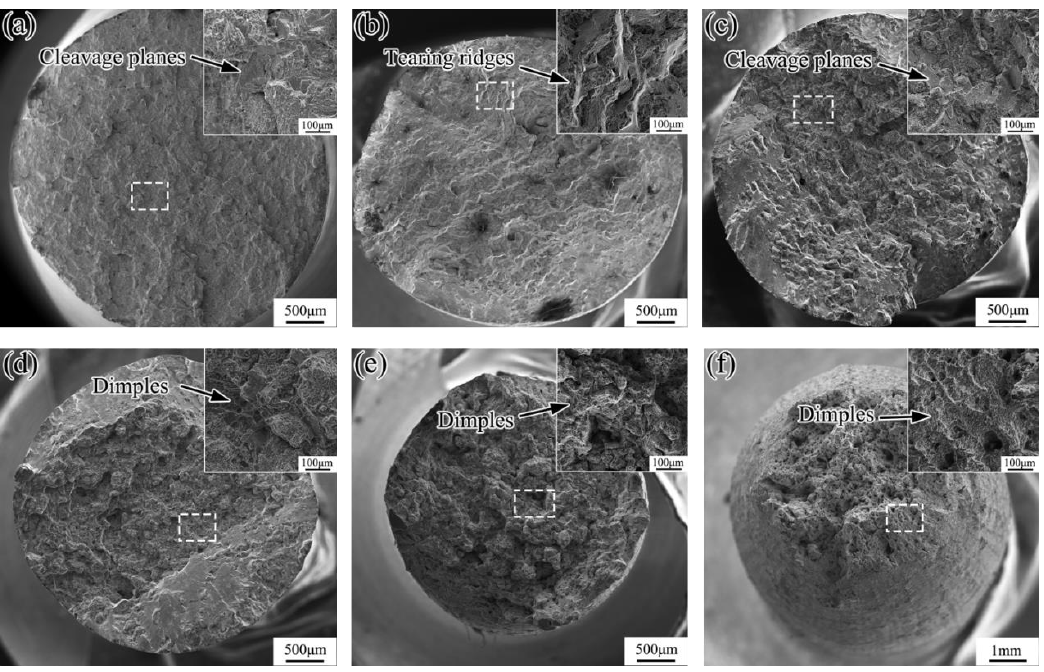
Figure 3. Fractographs of DZ951G alloy specimens at ( a ) room temperature, ( b ) 600 °C, ( c ) 760 °C, ( d ) 900 °C, ( e ) 1000 °C, and ( f ) 1100 °C.